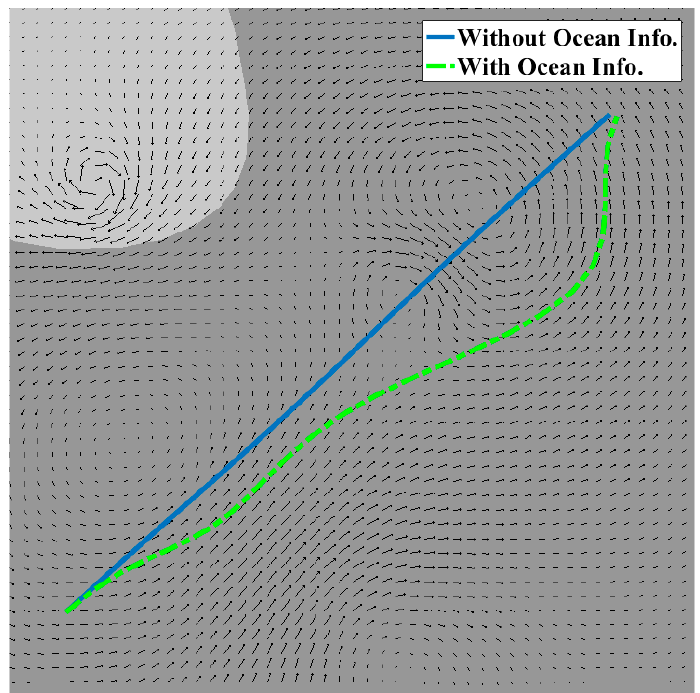
Figure 7. Comparison of the path planning results of the SHH algorithm without and with the ocean current information.